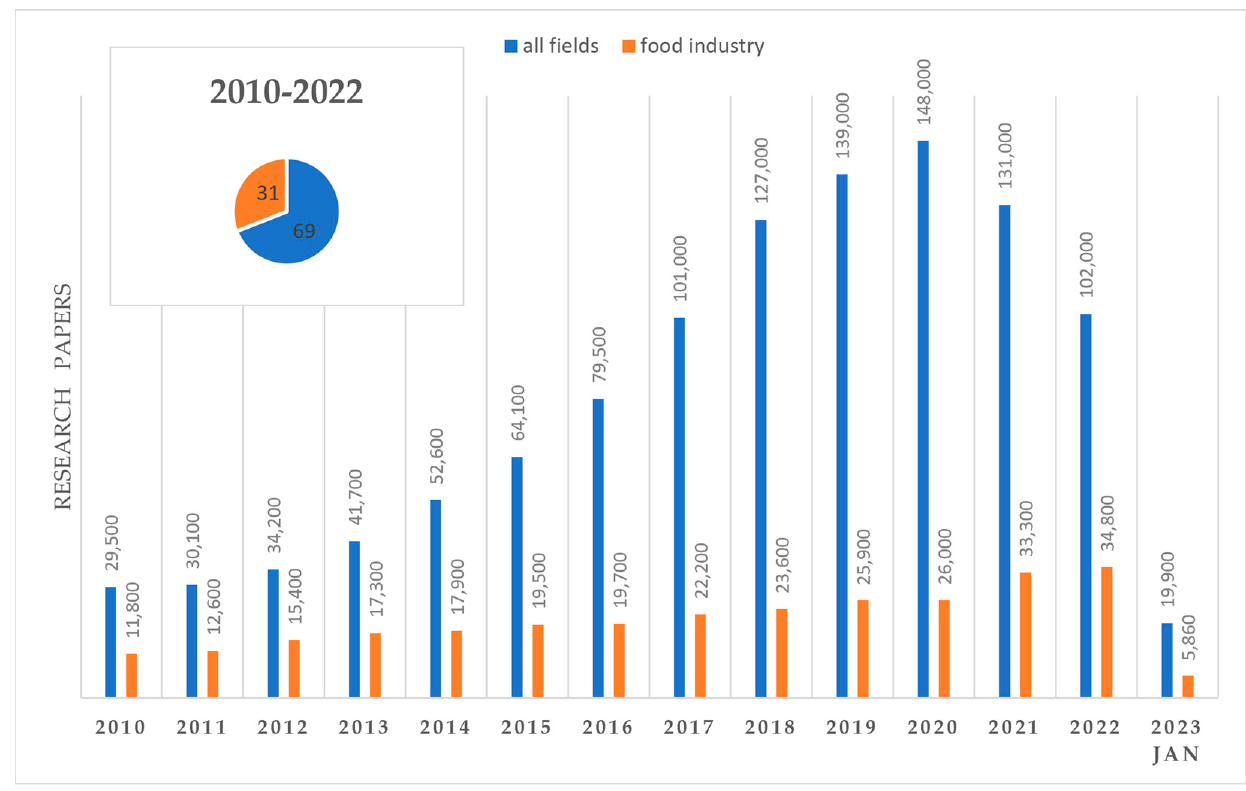
Figure 10. Number of publications from 2010 to 2023 (until the end of January) on 3D printing in all fields and in the food industry. The inset shows the average % distribution for the period 2010 – 2022.